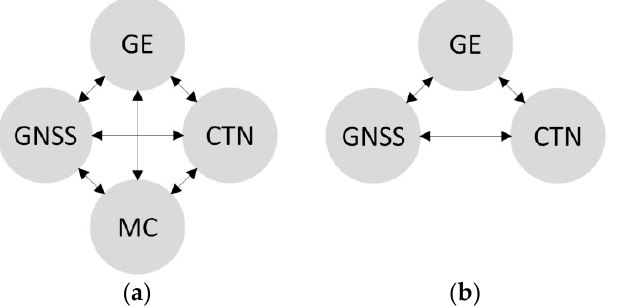
Figure 4. Conceptual scheme of comparisons: ( a ) planimetric component; ( b ) altimetric component.